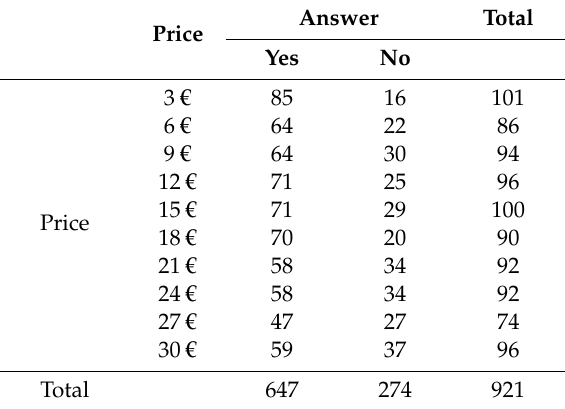
Table 2. Number of respondents in the corrected